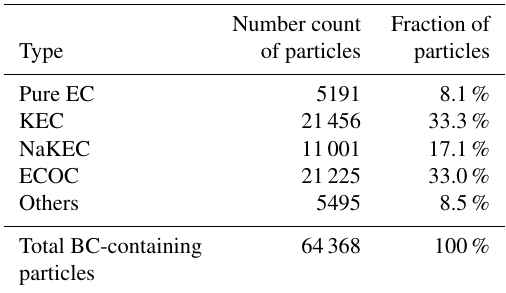
Table 1. Number counts and fractions of the five types of BC- containing particles detected by the